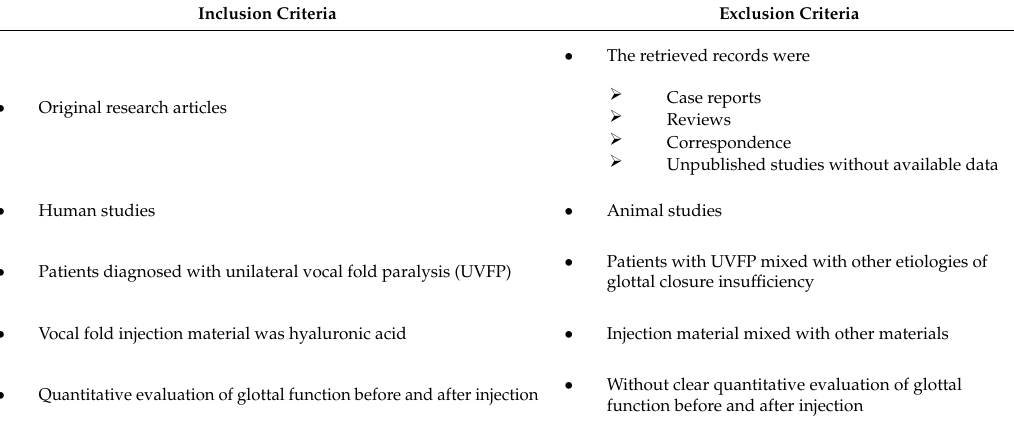
Table 1. Inclusion and exclusion criteria that were applied in this systematic review.